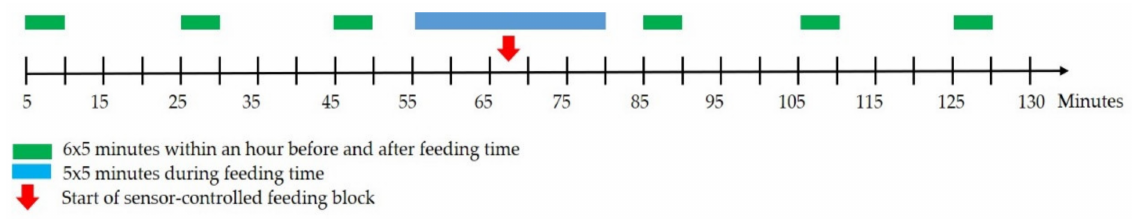
Figure 5. Schematic timeline of video-based observation periods (in minutes) around feeding time, which were performed twice a day during the noon and afternoon feeding. Five-minute intervals outside feeding are indicated in green and during feeding in blue. Table 3. Ethogram used in this study modified from Zonderland et al. (2011) [42]. Behaviour 1